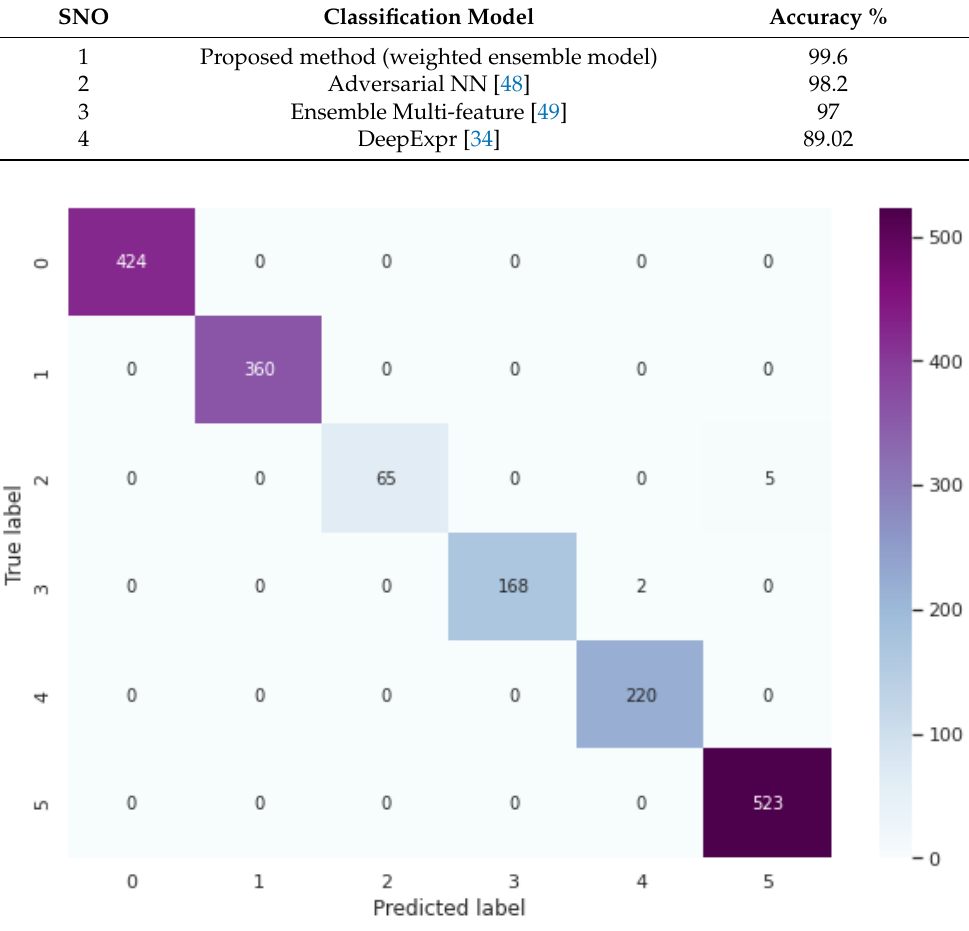
Figure 6. Confusion matrix on the FERG-DB dataset.